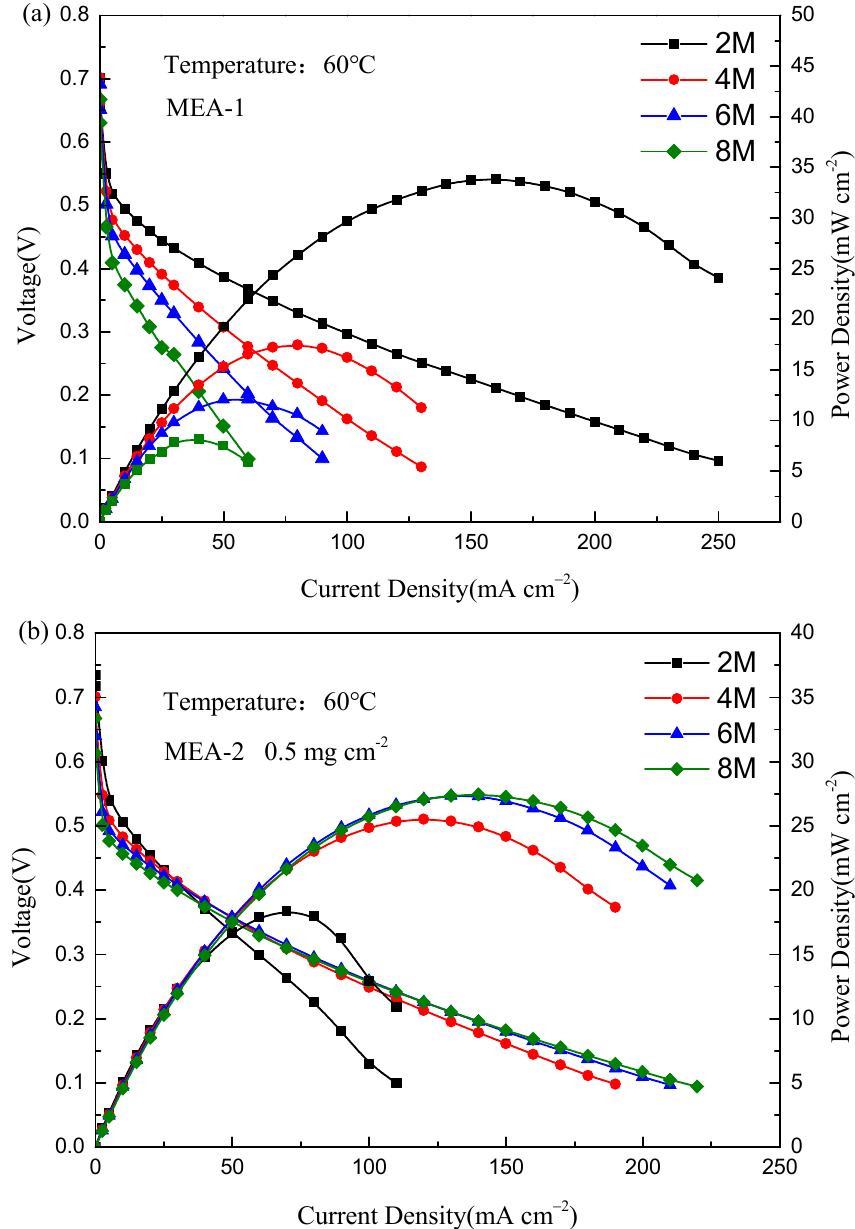
Figure 3. Comparison of the power performance of ( a ) conventional electrodes and ( b ) novel electrodes at different concentrations.